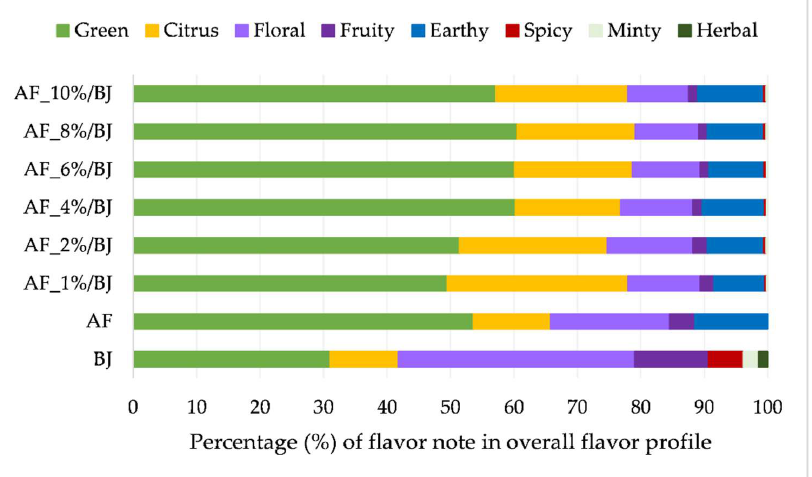
Figure 2. Percentage of specific flavor note in the overall flavor profile of blackberry juice, apple